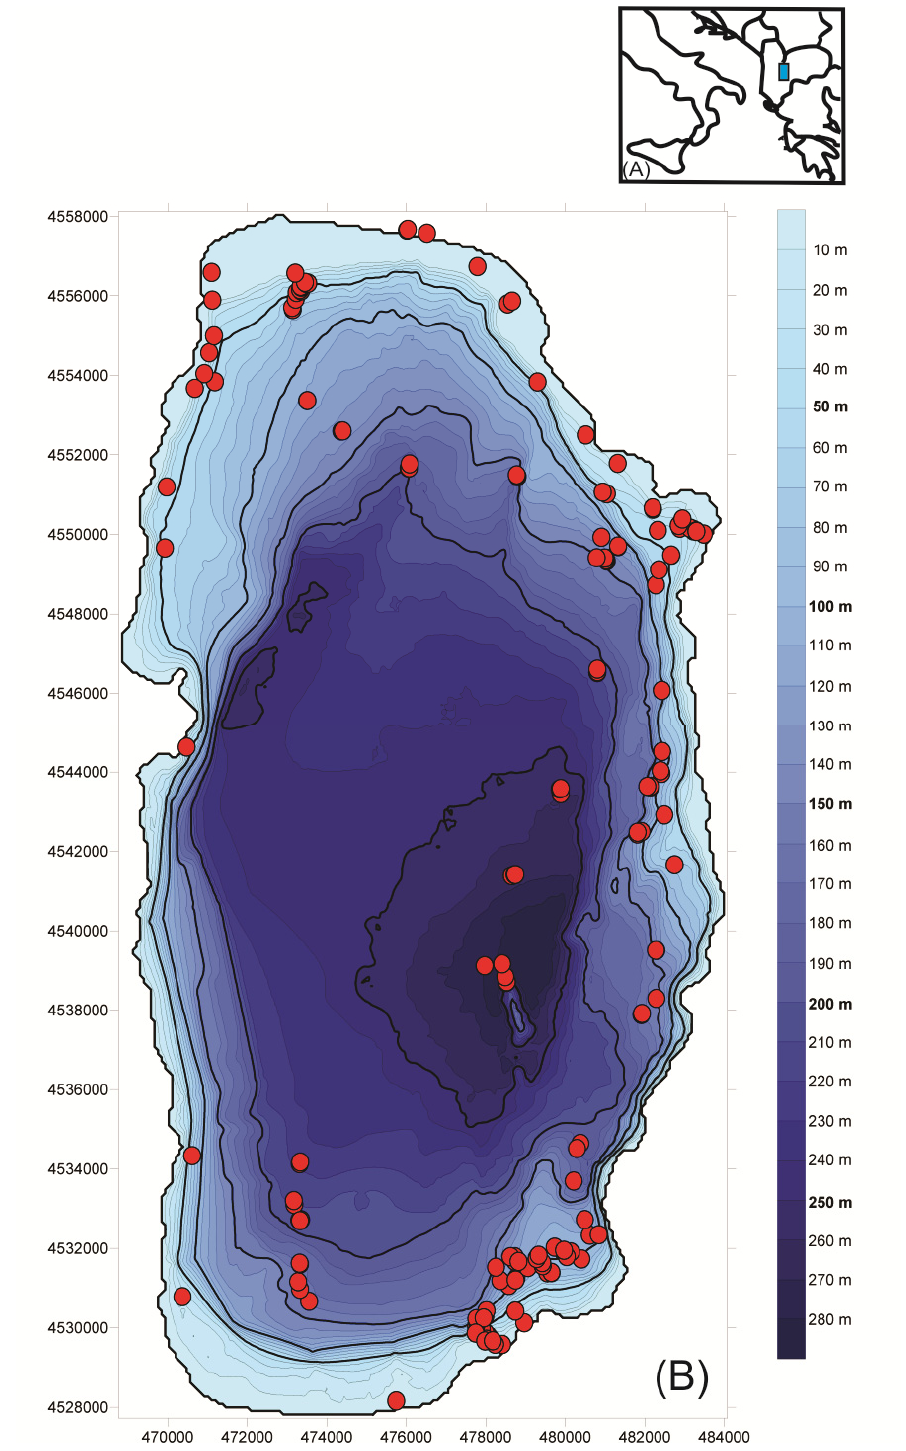
Figure 1. Inset map showing ( A ) the location of Lake Ohrid (rectangle) on the border of Macedonia/Albania and ( B ) a bathymetric map of the lake, displaying the sediment sampling